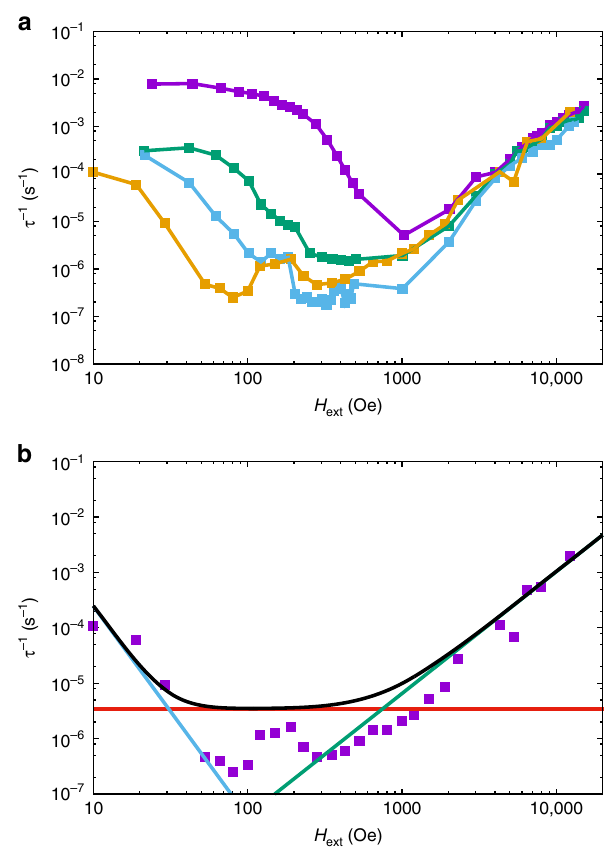
Fig. 7 Field dependence of magnetic relaxation rate with 164 Dy enrichment. a Magnetic relaxation rate for 1 (purple), 1a (green), 1b (light blue) and ~4% 164 Dy@ 2 (yellow; note log-log scale) at 2 K. Solid lines are a guide for the eye. b Magnetic relaxation rate for ~4% 164 Dy@ 2 (note the log-log scale). Black line is a fi t with Eq. (4) using the parameters in Table 1, however with ω 164 = 0.06(2) × 10 7 rad s − 1 ; red line is the Raman component alone, green line is the Direct component alone, blue line is the QTM component alone. Error bars are within the data